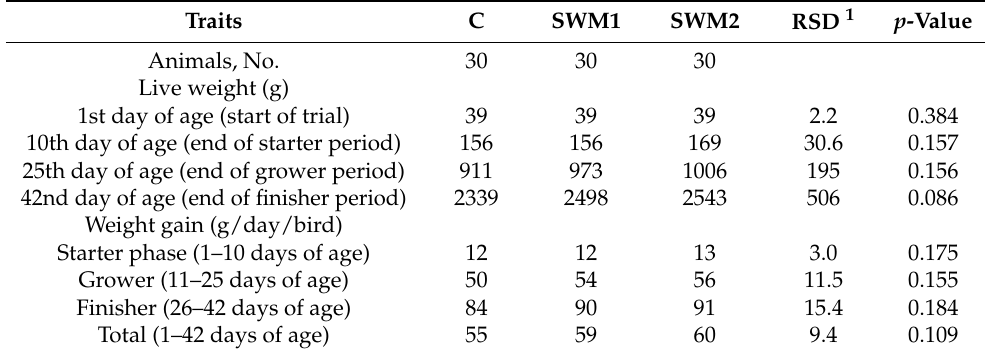
Table 3. Effect of the dietary inclusion either with 0% (Control) or 4% of defatted silkworm ( Bombyx mori L.) meal during starter (SWM1) or grower and finisher (SWM2) phases on broilers’ growth performances.